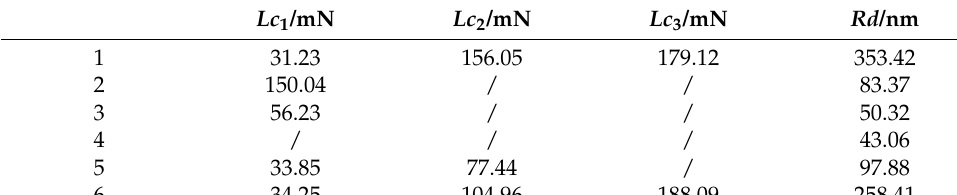
Table 2. Critical load and residual depth of the Si-B-C-N/DLC films.